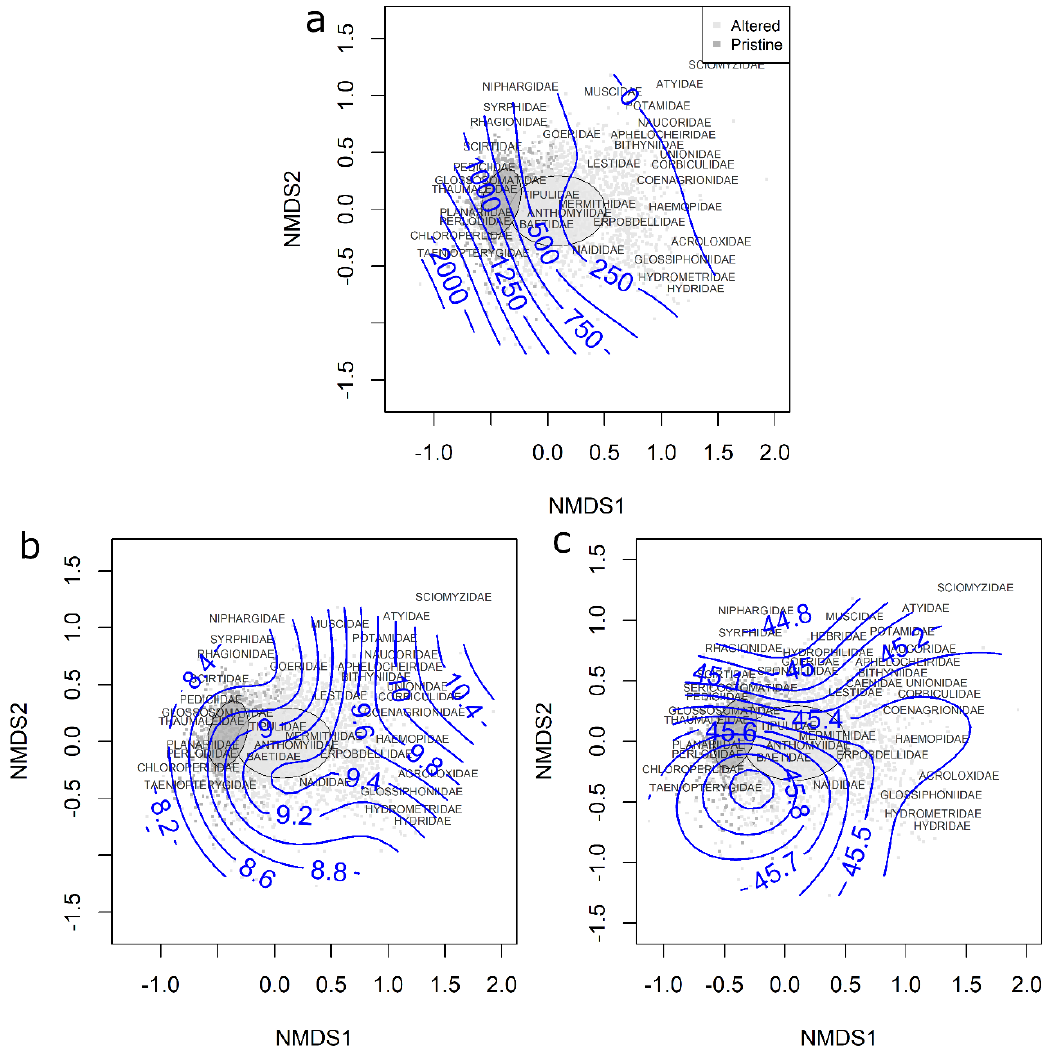
Figure 2. Nonmetric multidimensional scaling (NMDS) ordination plot for aquatic macroinvertebrate assemblages where the a-priori identified alteration status are colored. Dark gray denotes the assemblages that belong to pristine sites ( n = 534) while light gray denotes those assemblages that belong to sites where an impact is present ( n = 2563). Shaded ellipses represent the 95% confidence interval surrounding the centroid of each impact class in the ordination space. Overlaid smooth surface display blue splines using generalized additive models (GAMs) for Altitude ( a ), Longitude ( b ) and Latitude ( c ). Numbers on the splines represent respectively meter above sea level and WGS84 coordinates. Macroinvertebrate families are positioned in the ordination space with uppercase labels, as weighted averages. 3D stress = 0.16.